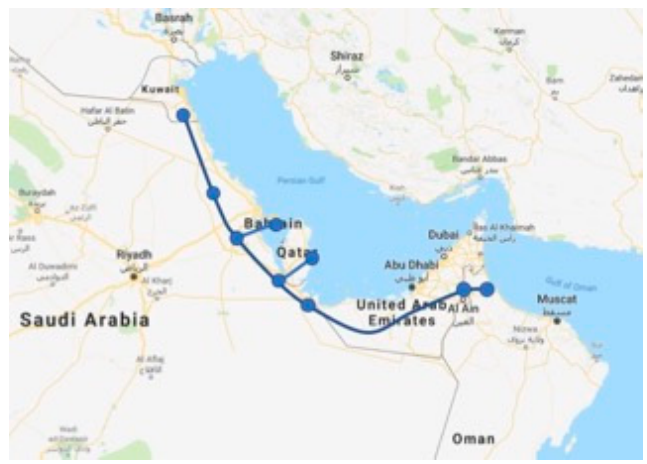
Figure 1. Gulf Cooperation Council’s (GCC) Interconnection Project [34].